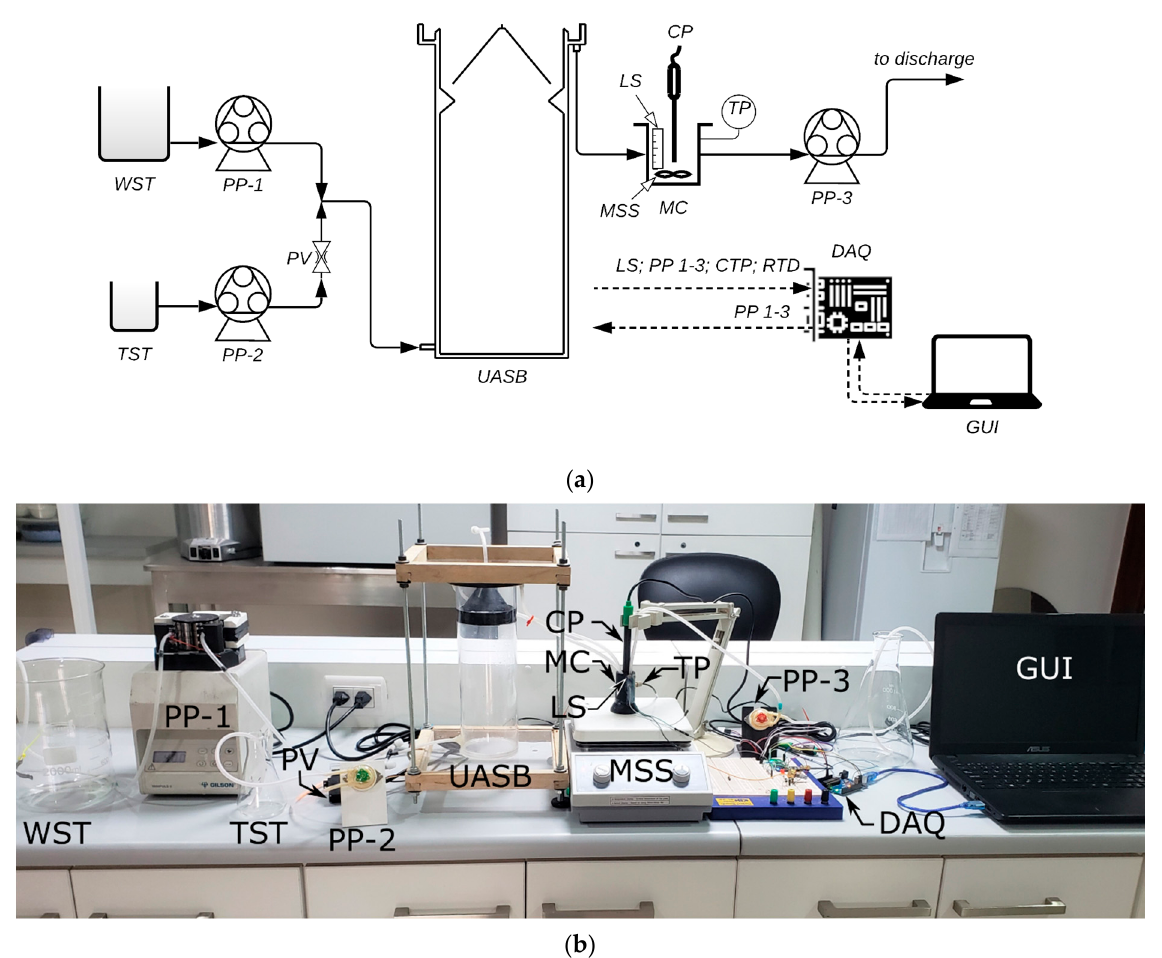
Figure 1. Automated RTD measurement system: ( a ) Schematic representation; ( b ) Actual system.